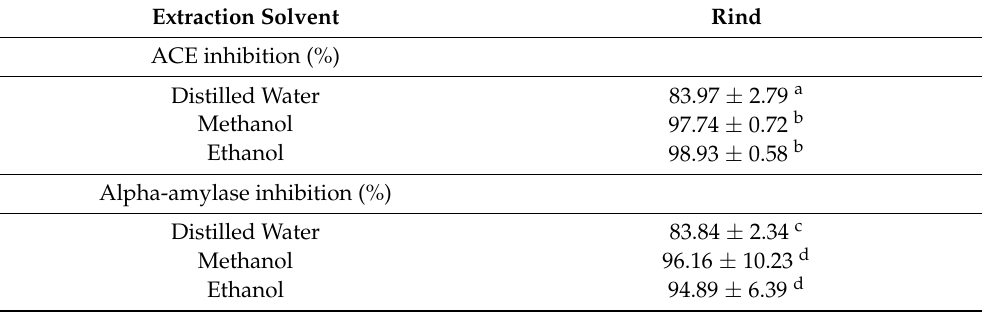
Table 2. The anti-hypertensive and hypoglycemic properties of pulasan rind in various extraction